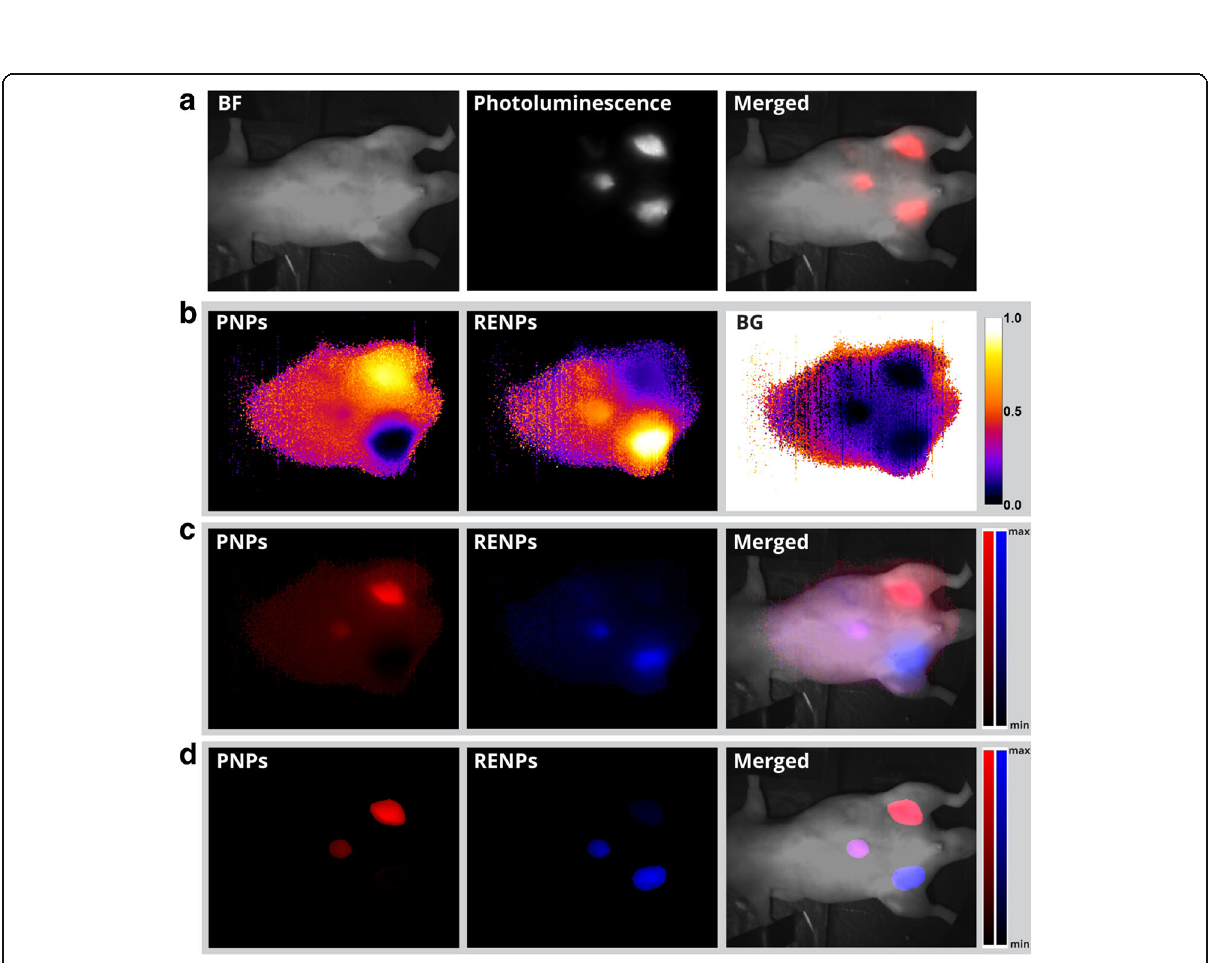
Fig. 6 HSI of mouse subcutaneously injected with PNPs (top right injection site), RENPs (bottom right), and RENPs/PNPs mixture (left). a Bright field (SWIR), SWIR PL, and merged images acquired with 850-nm-long pass emission filter. b Abundances of PNPs, RENPs, and background (BG). c Corresponding reconstructed intensity images. d PL intensity images reconstructed from abundances with threshold level of 15% and PL/bright field merged